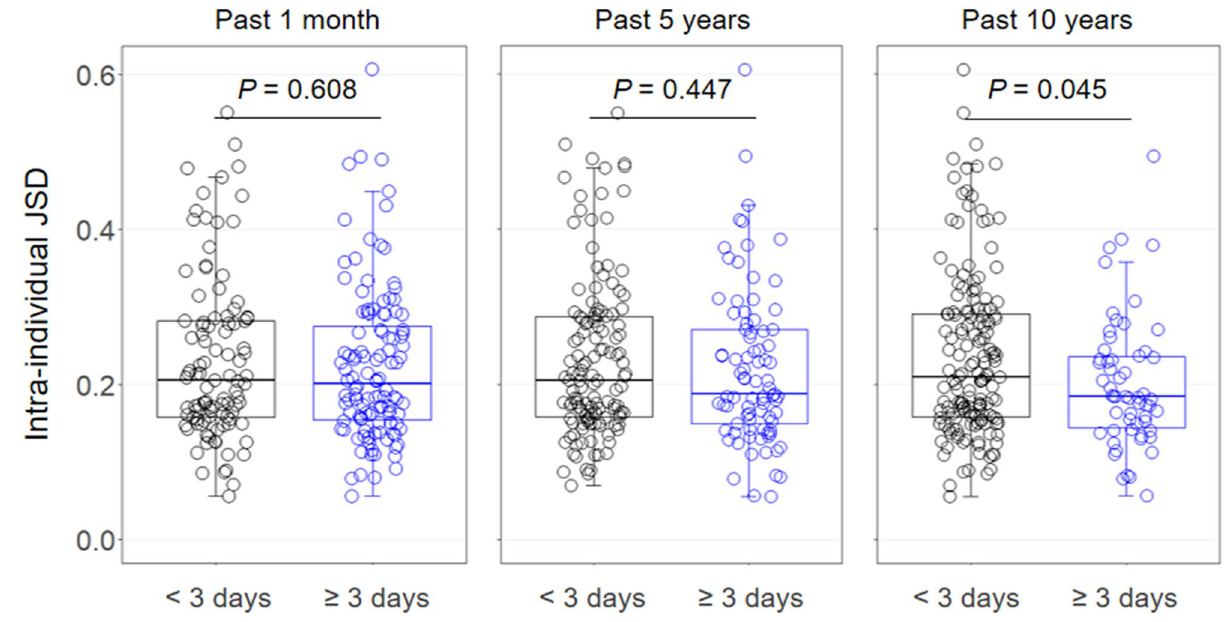
Figure 4. Intra-individual Jensen-Shannon distance (JSD) in subjects consuming fermented milk products containing Lacticaseibacillus paracasei strain Shirota (LcS) < 3 or ≥ 3 days/week during the past 1-month, 5-year and 10-year periods. Independent differences in the JSD between groups were assessed by analyses of covariance, after adjusting data for age, sex, body mass index, smoking status, and alcohol